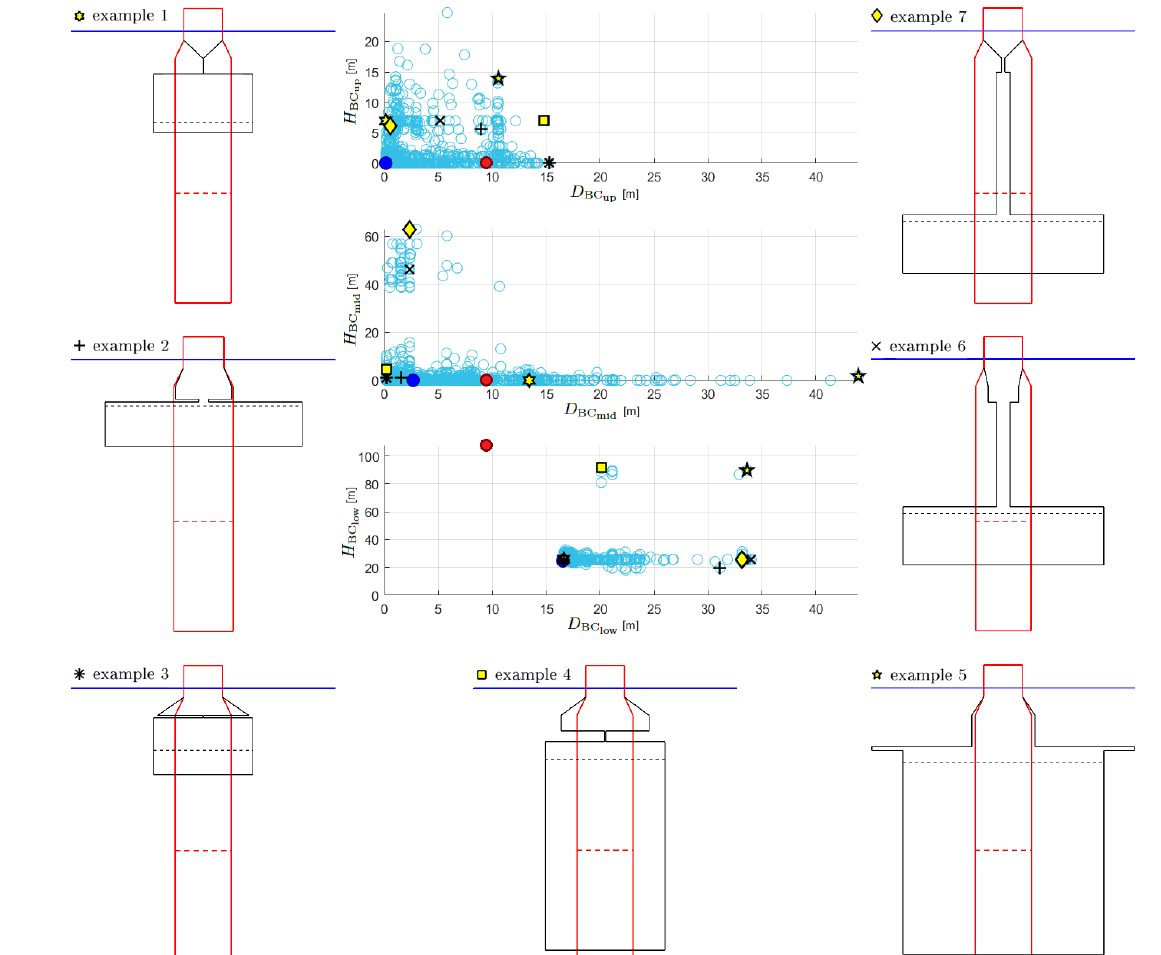
Figure 5. Exemplary potential innovative floater geometries selected from the individuals complying with all constraints: the individuals complying with all constraints are represented by unfilled light blue circles, the best-performing individual is marked with a dark blue filled circle, and the value corresponding to the reference FOWT system is plotted as a red filled circle with the associated shape drawn with a red line.